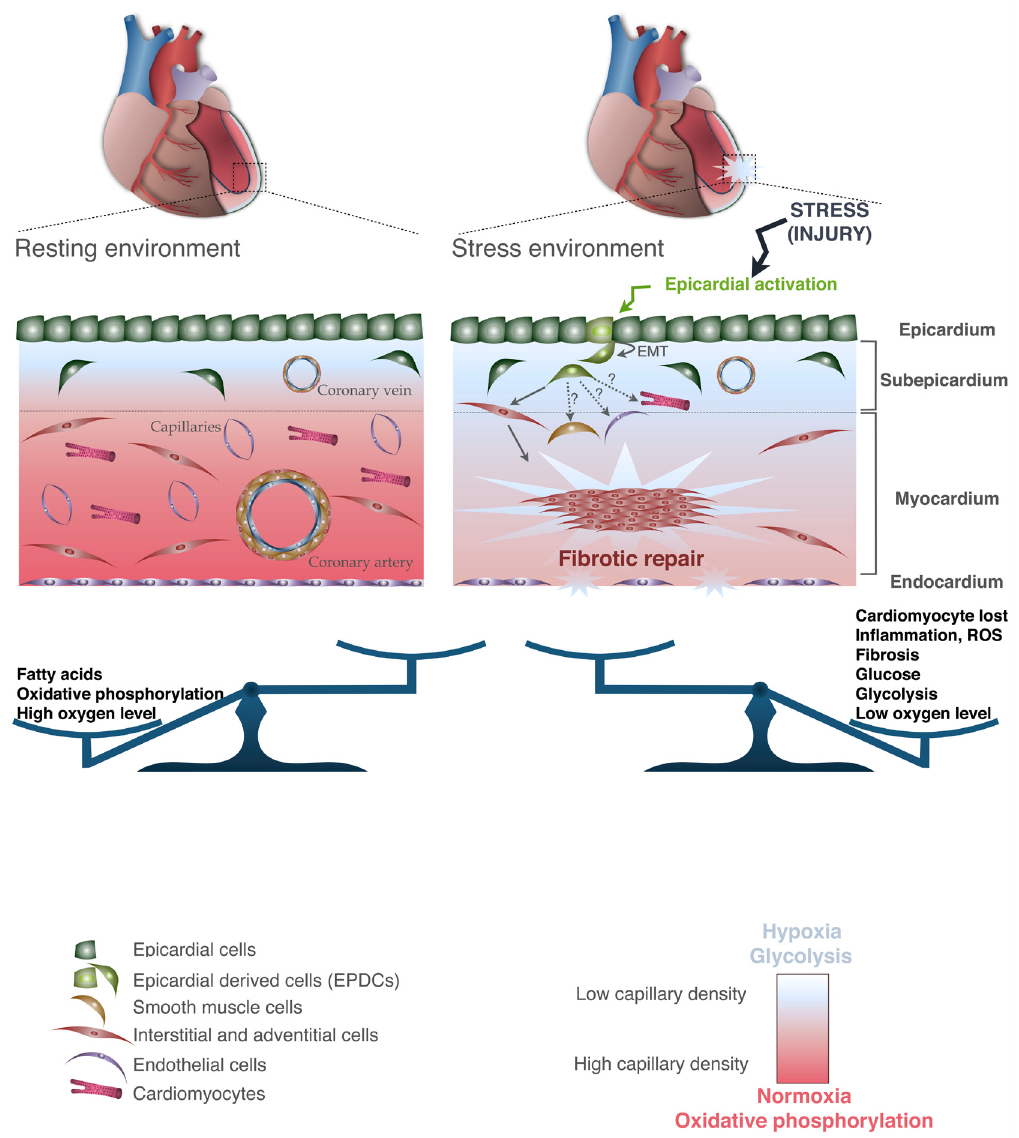
Figure 3. Adult heart under physiological conditions and after injury. Both the microenvironment and the cellular component are represented. A color code was assigned and followed to define each of the cardiac cell types and their associated cells (depicted in the legend). EMT, epithelial-to-mesenchymal